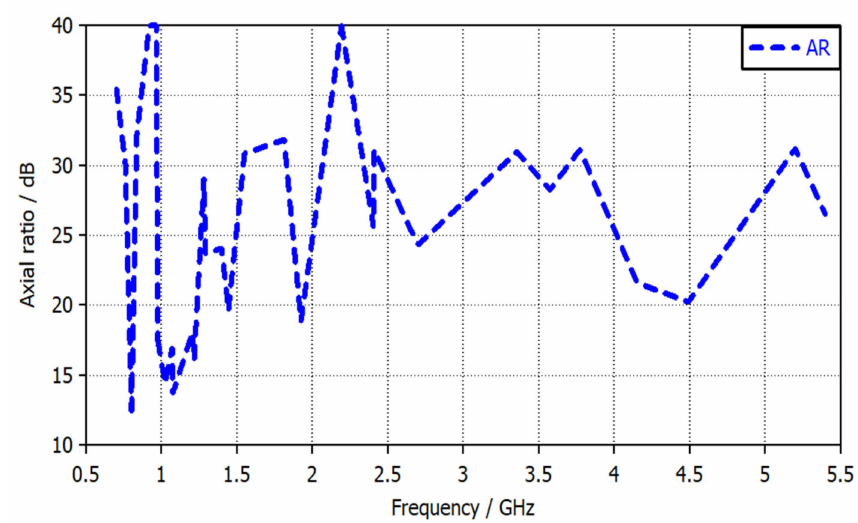
Figure 17. The simulated axial ratio in dB versus